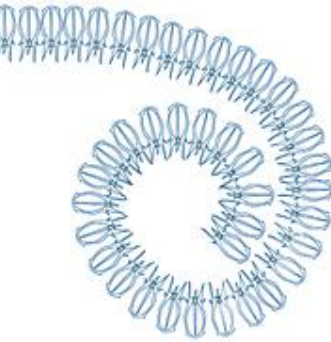
Figure 3. Group of salps (salp chain).